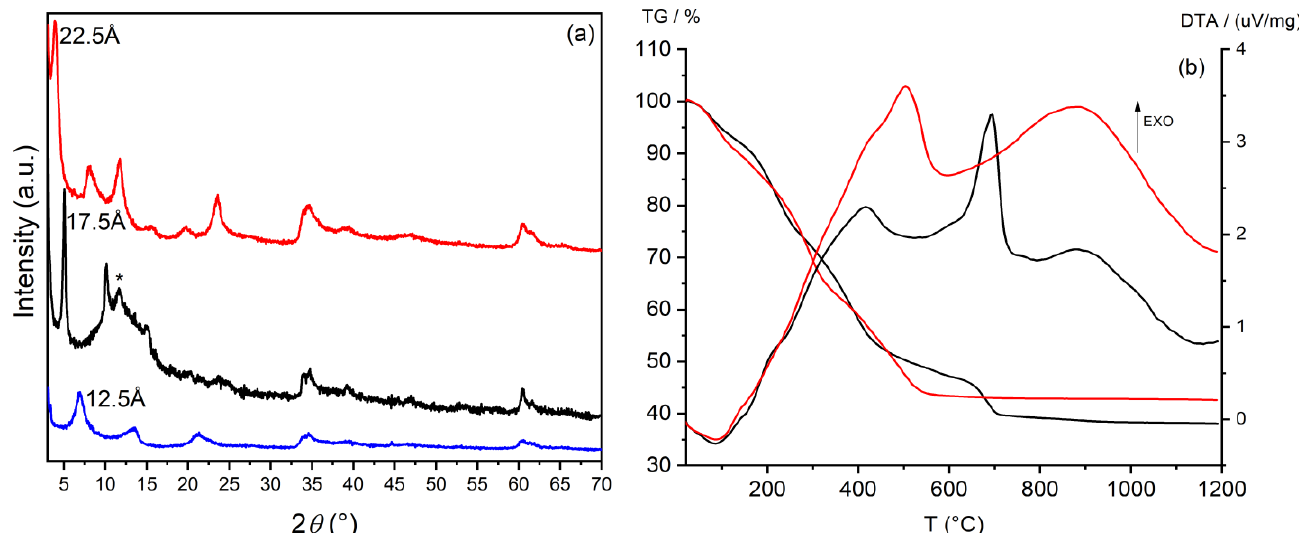
Figure 2. XRD patterns of ZnAl-Ac (blue line); ZnAl-CFZ (black line) (the asterisk indicates the presence of ZnAl-OH phase); ZnAl-NAL (red line) ( a ). TGA and DTA curves of ZnAl-CFZ (black line) and ZnAl-NAL (red line) ( b ); operative conditions: heating rate: 10 °C/min, air. The thermal behavior of the samples was investigated by TGA and DTA (Figure 2b). Table 1. Sample acronym, composition, and weight percentage of antibiotic (A)